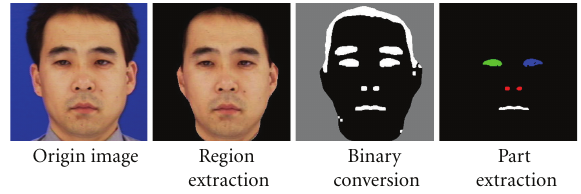
Figure 3: Images after di ff erent filtering steps.